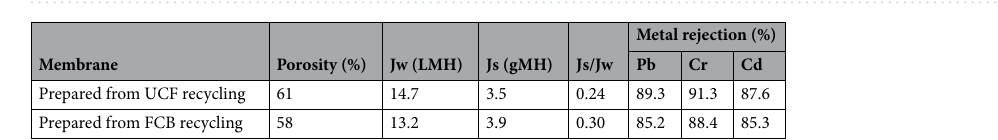
Figure 3. SEM images of the prepared membranes.